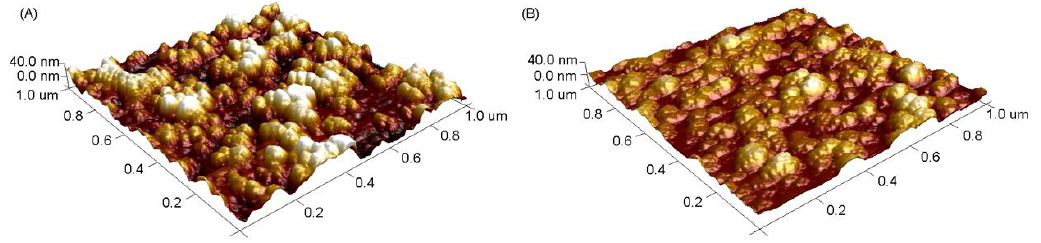
Figure 3. Atomic force microscopy images of quartz crystal microbalance with dissipation monitoring (QCM-D) sensors coated with ( A ) molecularly imprinted polymers (MIPs) and ( B ) non-imprinted polymers (NIPs).